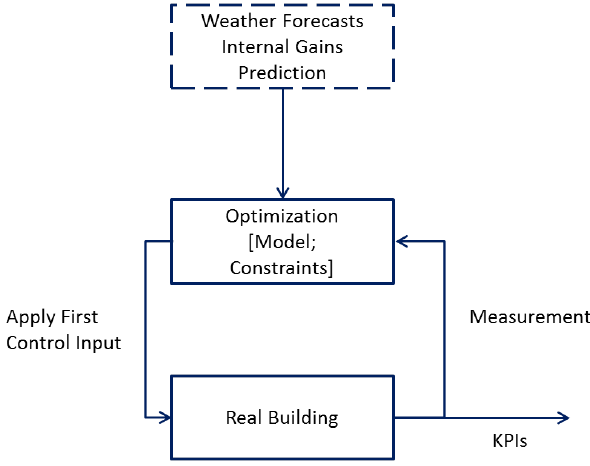
Figure 1. The model predictive control paradigm for building control optimisation (adapted from